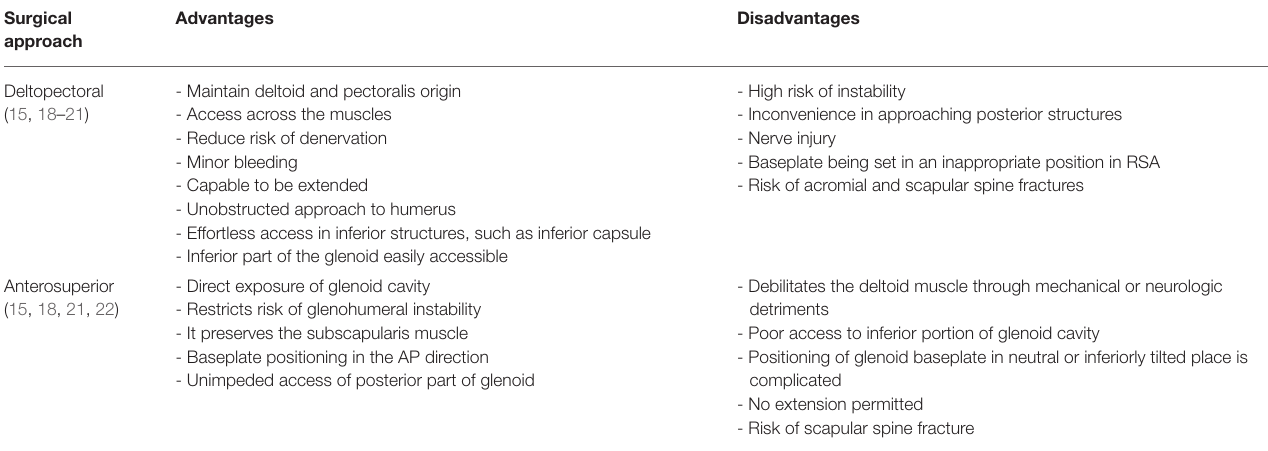
TABLE 1 | Advantages and disadvantages of surgical